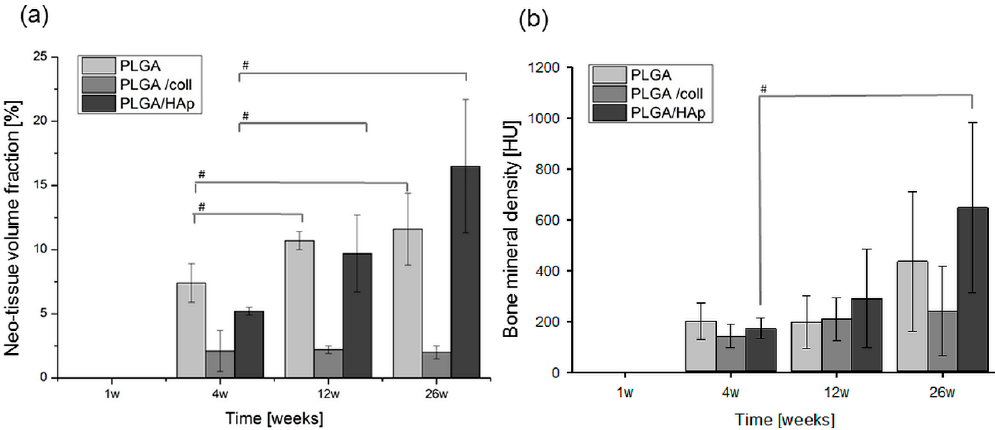
Figure 7. Neo-tissue volume fraction assessed by morphometric analysis of histological pictures ( a ) and bone mineral density measured by µCT ( b ) at the implantation site of PLGA, PLGA/coll, and PLGA/Hap scaffolds after 1, 4, 12, and 26 weeks post-implantation; statistically significant differences at # p < 0.05 according to ANOVA.